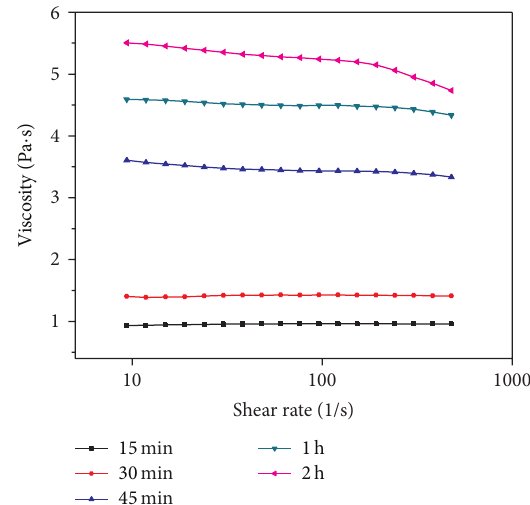
Figure 6: GPC plots of polyols with different reaction time.